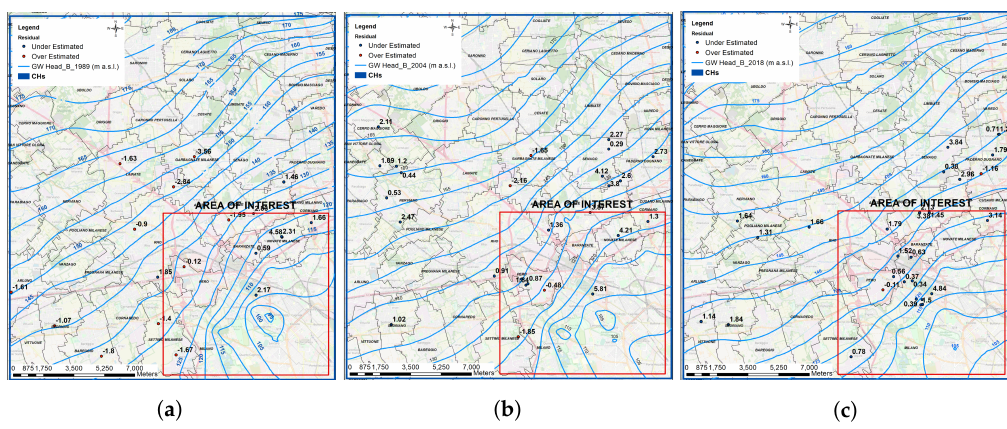
Figure A2. Scatter plot observed vs. simulated head relative to the overall model.